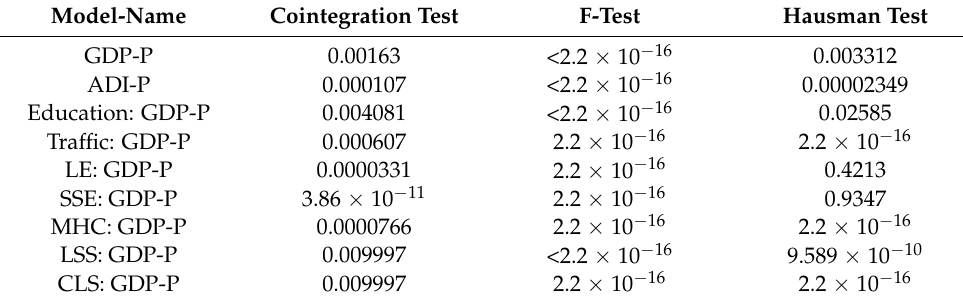
Table 4. Test results of life satisfaction and model variables.